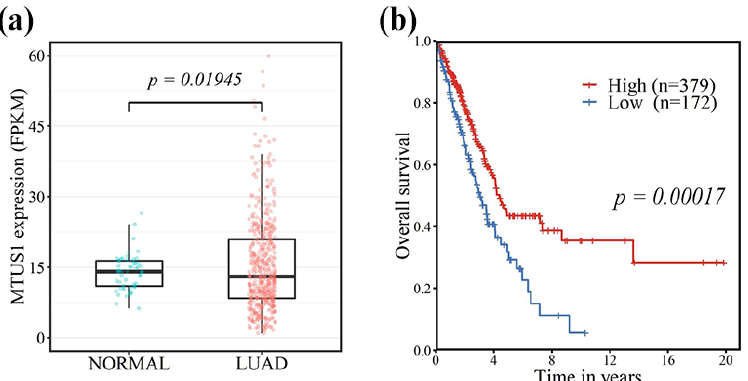
Figure 3. Data analysis from the Cancer Genome Atlas (TCGA) showing significantly lower mRNA expression of MTUS1 in lung adenocarcinoma than in normal lung tissue ( a ). In addition, there was a significant difference in overall survival according to MTUS1 mRNA expression (Kaplan–Meier method with log-rank test) ( b ).